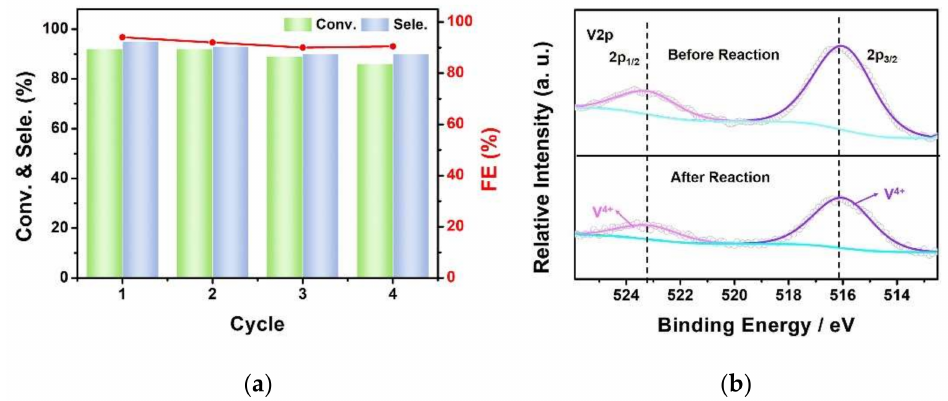
Figure 7. ( a ) Recycle test for the electrocatalytic selective oxidation of BA by 1 ; ( b ) V 2p XPS spectra of 1 before and after the